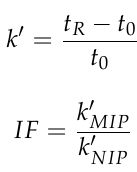
Figure 4. Chemical structures of the related compounds.